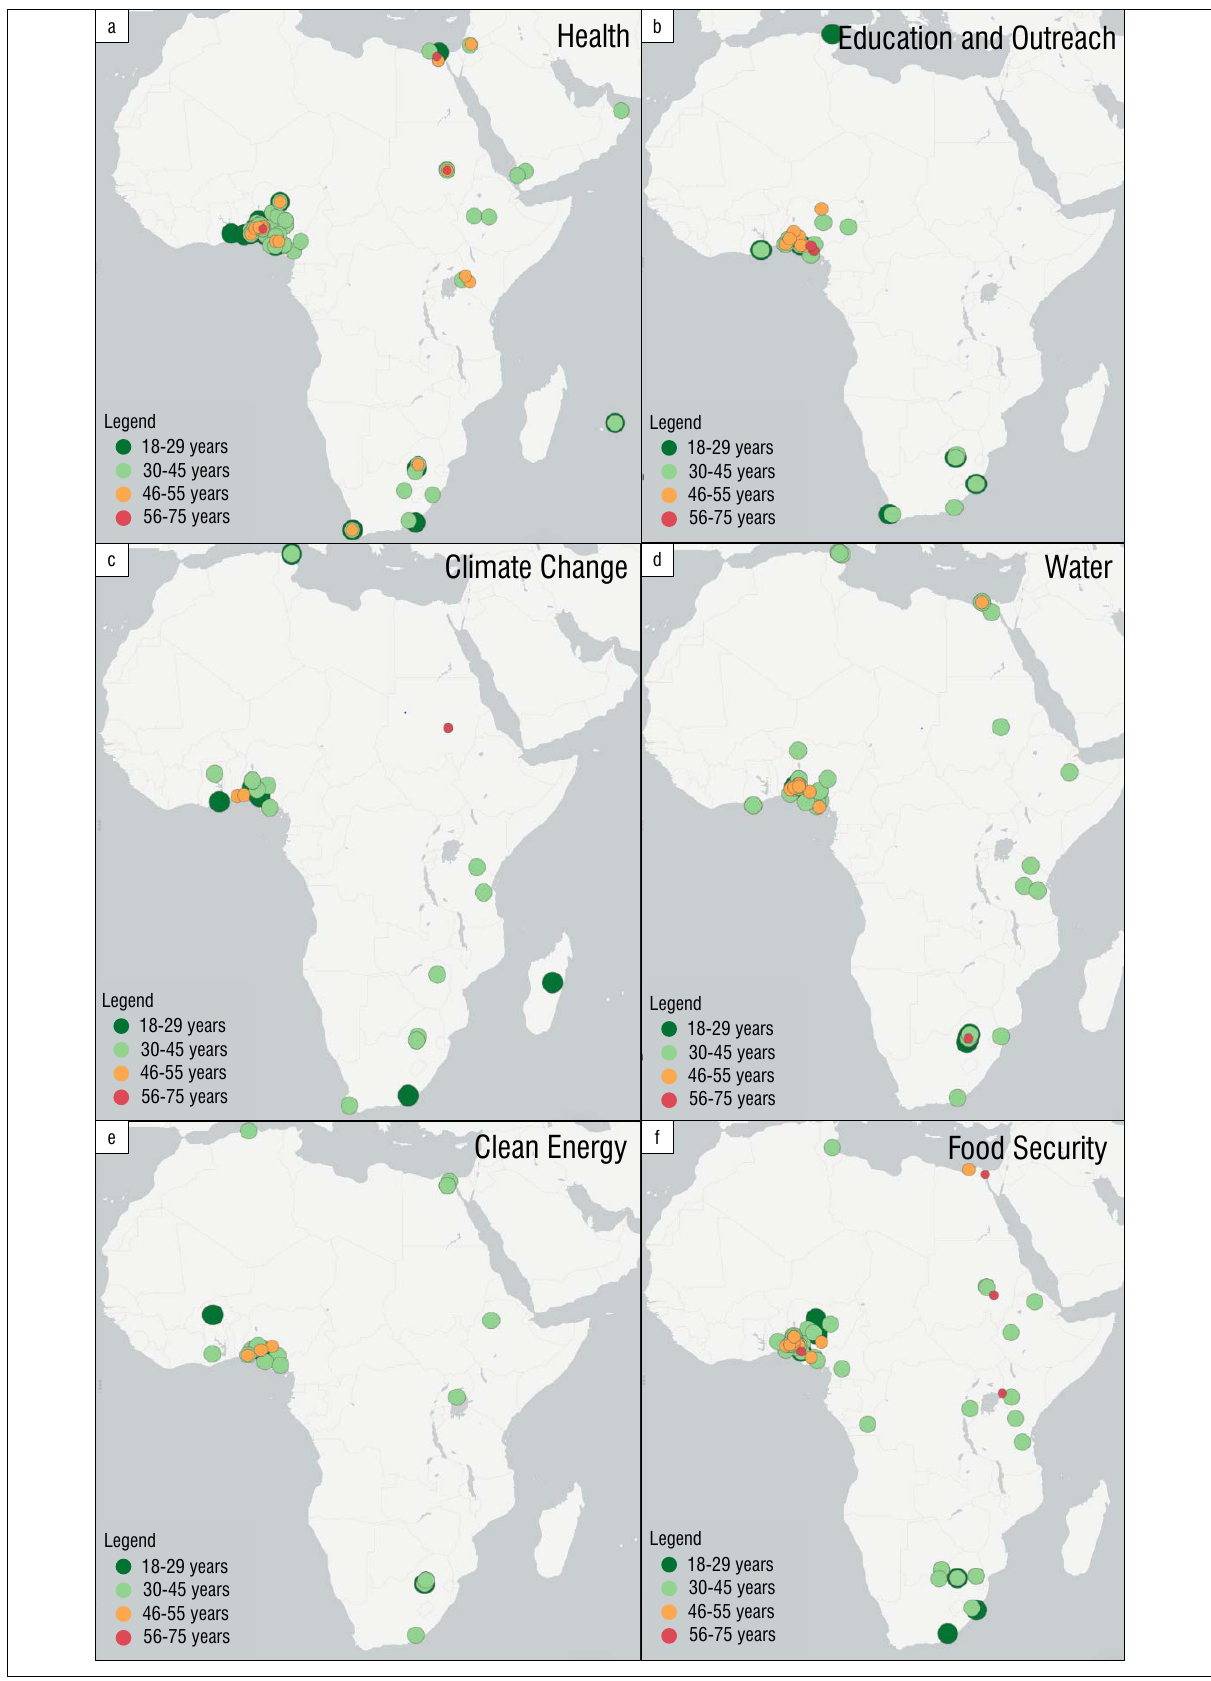
Figure 6: The most common themes selected by submitters, by age